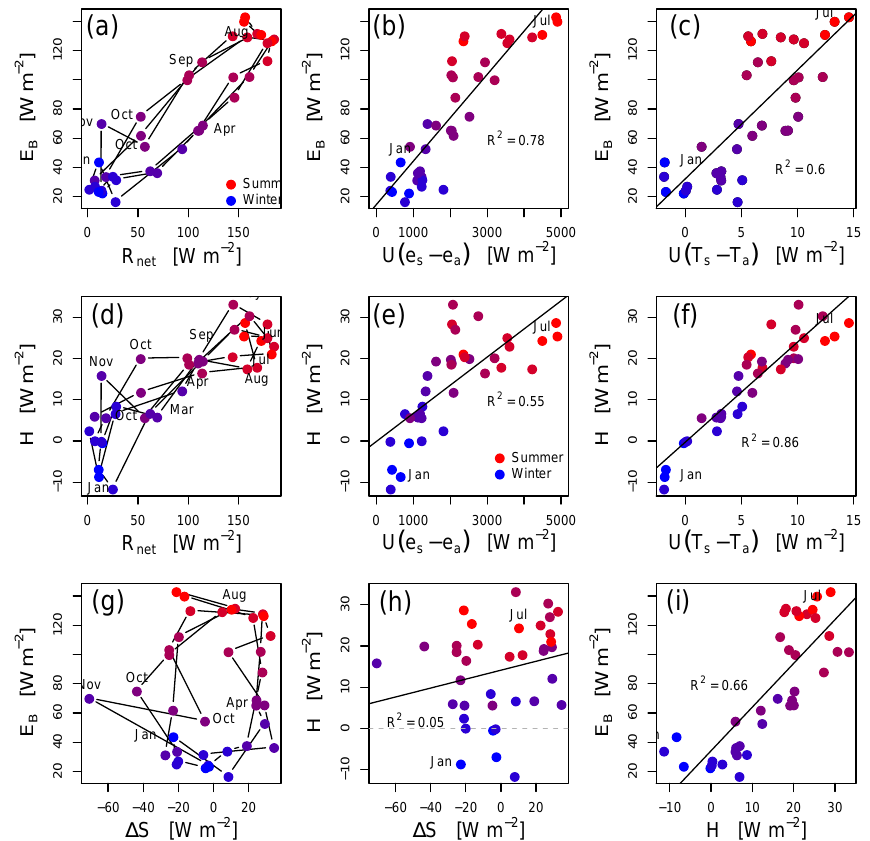
Figure 6. Correlations between various components of the heat budget equation. Dots represent monthly data over the 3-year survey period. Dot colour indicates the season (with red in summer and blue in winter). When seasonal cycles are apparent, line segments link successive data points.